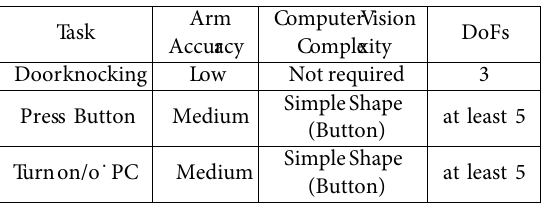
Table 1. Robottask vs complexity